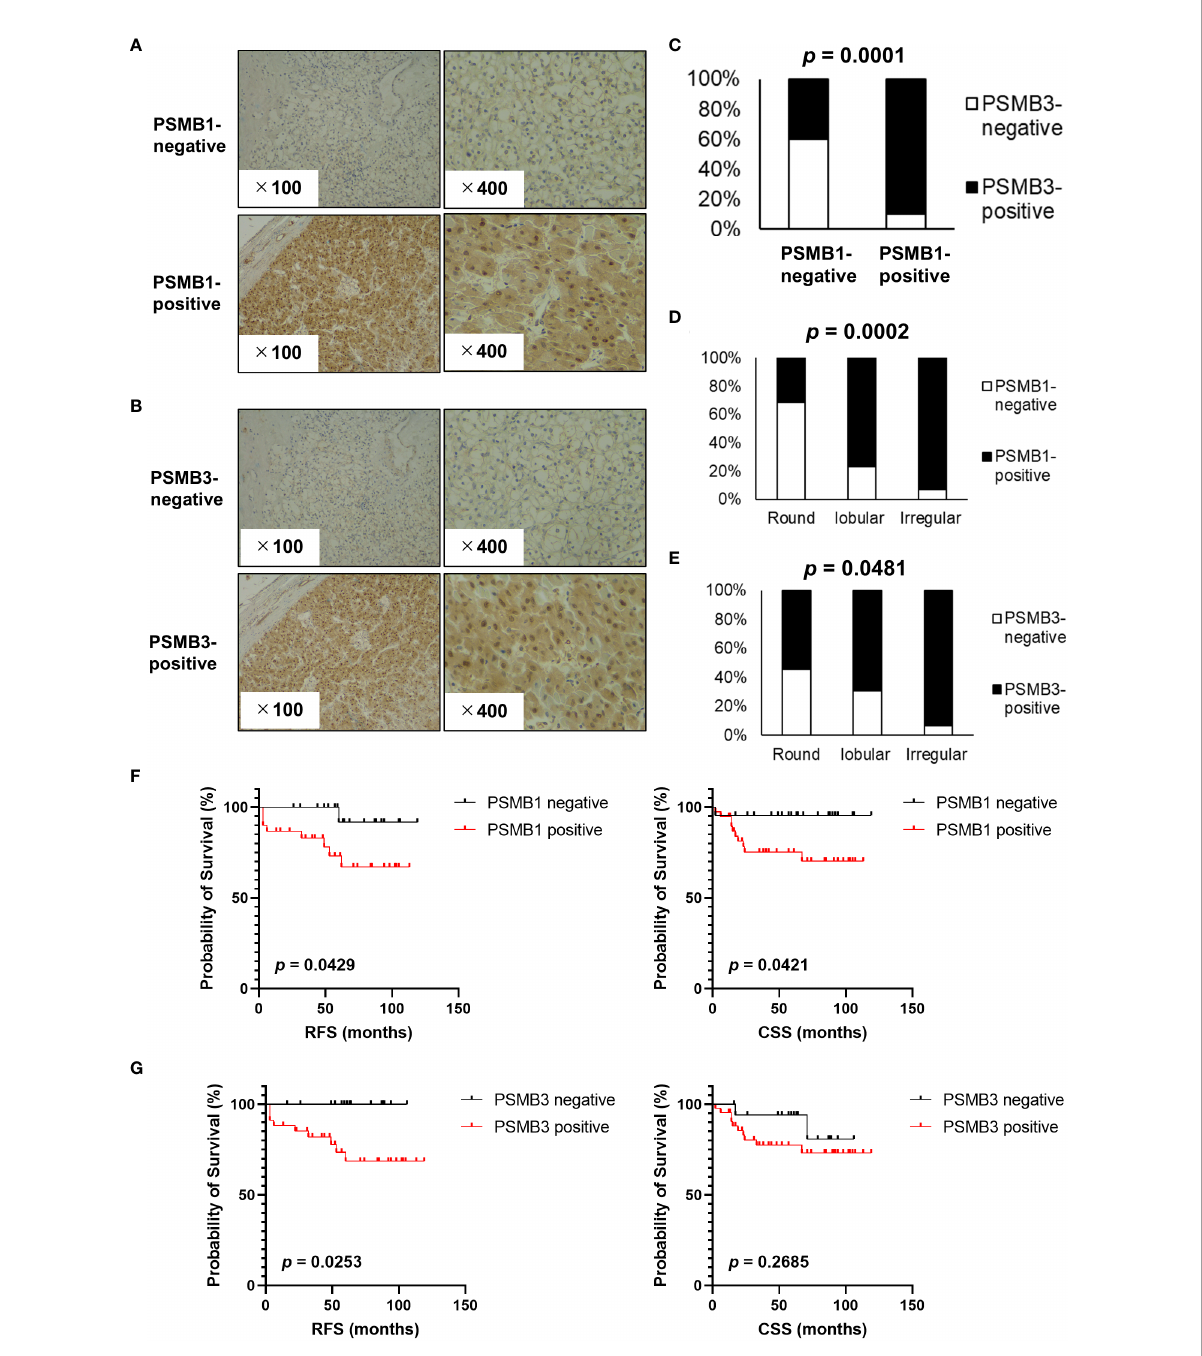
FIGURE 5 Evaluation of PSMB1 and PSMB3 expression in ccRCC. Immunohistochemistry of PSMB1 and PSMB3 was performed using specimens obtained from patients with ccRCC who received radical, cytoreductive, or partial nephrectomy at our institution. (A, B) Typical fi ndings of positive and negative results are shown for PSMB1 (A) and PSMB3 (B) . (C) Results of chi-square test comparing the immunohistochemistry of PSMB1 and PSMB3. (D, E) Both PSMB1-positive (D) and PSMB3-positive (E) cases were signi fi cantly more common in the round, followed by lobular and then irregular types. (F) PSMB1-positive cases had signi fi cantly worse recurrence-free survival and cancer-speci fi c survival. (G) PSMB3-positive cases also had signi fi cantly worse recurrence-free survival. DFS, disease-free